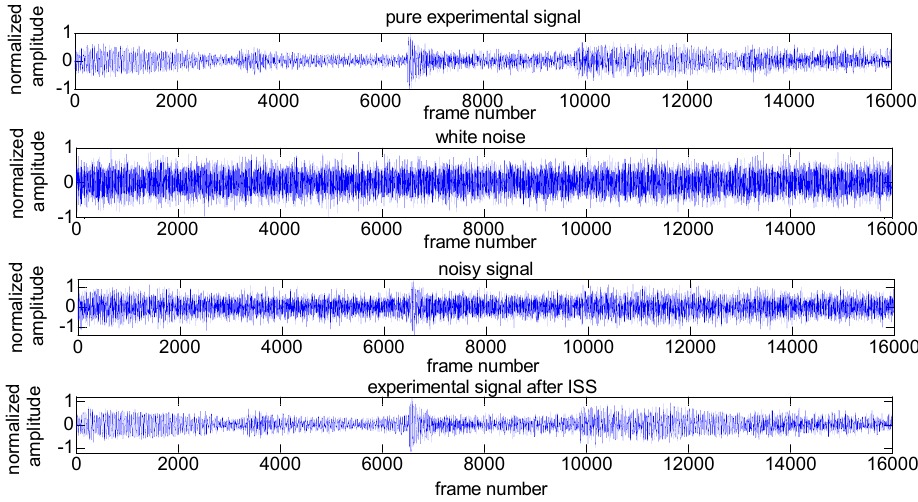
Figure 5. Results of experimental signal after ISS with SNR = 0 dB.